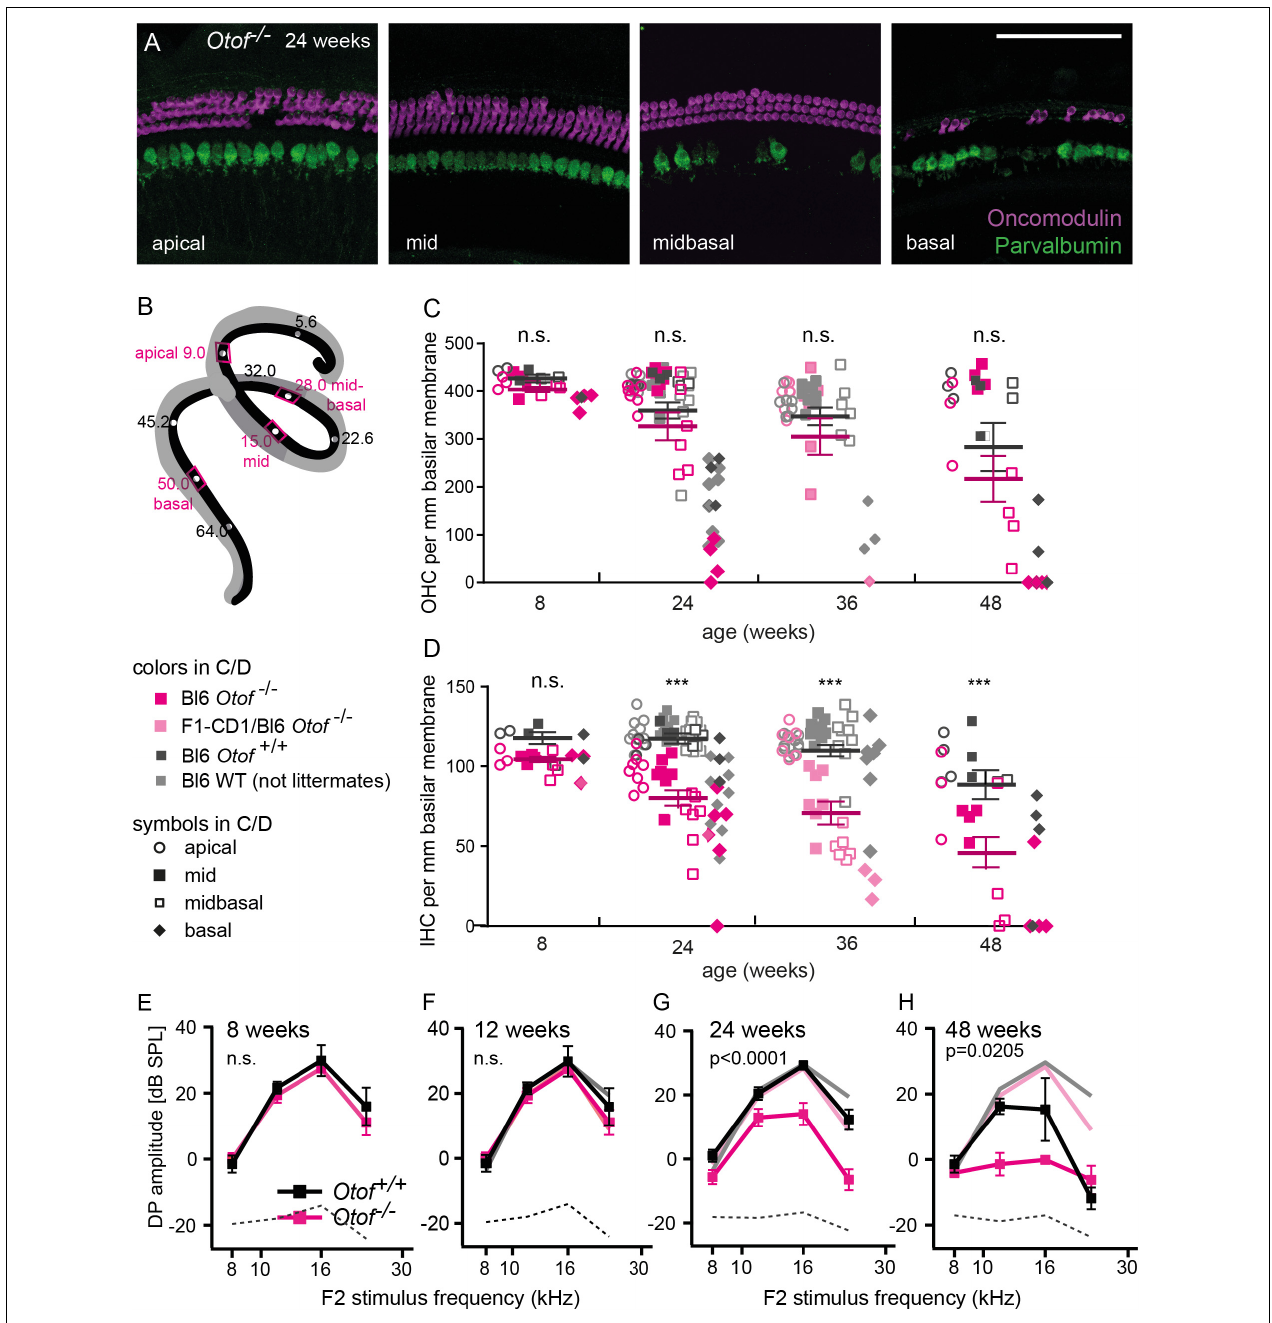
FIGURE 1 | Inner and outer hair cell degeneration in absence of otoferlin. (A) Maximum projections of confocal micrographs of immunolabelled Otof − / − whole mount organs of Corti in four regions of the cochlea with IHCs labeled for parvalbumin (green) and OHCs labeled for oncomodulin (magenta). Representative example of an Otof − / − specimen at 24 weeks of age, scale bar: 100 µ m. (B) schematic drawing of the mouse organ of Corti, with the regions analyzed in this study indicated in magenta. (C) number of OHCs per mm basilar membrane at 8, 24, 36, and 48 weeks of age in Otof + / + (gray, mean ± SEM black) and Otof − / − (magenta, mean ± SEM dark magenta) mice. Otof − / − mice at 36 weeks of age were of mixed background (F1-CD1xC57BL6), all other mice of C57BL/6 background. Across all age groups and tonotopic regions, the number of OHCs in Otof − / − is reduced to 88% of Otof + / + counts ( p = 0.0705, 2way ANOVA followed by Sidac test). (D) number of IHCs per mm basilar membrane indicated a strong decay of the number of IHCs in the absence of otoferlin (reduction to 69% of WT, p < 0.0001, 2way ANOVA). *** indicate age groups in which the reduction in IHC numbers across tonotopic regions was significant ( p < =0.0001, post hoc Sidac test after 2way ANOVA). E-H, Amplitude of the 2f1-f2 distortion product across four different stimulation frequencies (60 dB sound pressure level) at the age of 8 weeks (E) , 12 weeks (F) , 24 weeks (G) , and 48 weeks (H) . In panels (F–H) , the values obtained at 8 weeks are plotted in light colors for comparison. Note that both mouse lines are of C57BL/6 background, explaining the decline of DPOAE amplitudes in the wild-type controls at 48 weeks of age. The amplitude reduction in Otof − / − compared to Otof + / + is significant at 24 ( p < 0.0001, n = 5/6) and 48 weeks ( p = 0.0205, n = 4 each) of age but not at 8 ( n = 6 each) and 12 weeks ( n = 5/3) (2way ANOVA for genotype effect across frequencies). Dotted line: noise floor.